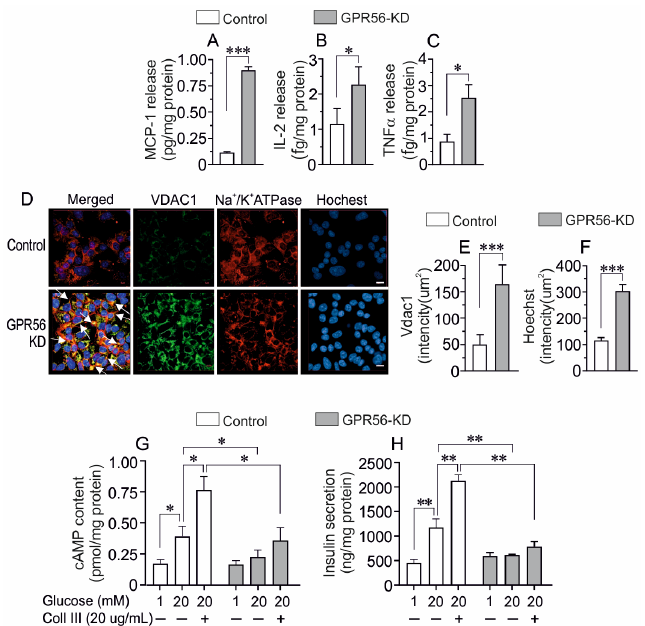
Figure 6. The effect of GPR56-KD on VDAC1 expression, cytokine release, cellular cAMP, and glu- cose-stimulated insulin secretion in human EndoC β H1 cells. GPR56-KD increased the release of MCP-1 ( A ), IL-2 ( B ), and TNF α ( C ) upon 6 h recovery culture from scramble control and GPR56-KD EndoC β H1 cells performed at six different occasions is shown. GPR56-KD increased VDAC1 ex- pression and caused its mistargeting to the plasma membrane detected as co-localization with Na+/K+ ATPase, seen as orange-yellowish fluorescence (merged) concomitant with an increased Hoechst intensity in EndoC β H1 cells ( D ) VDAC1 (green), Na + /K + ATPase (red), and Hoechst (blue). Calculation of VDAC1 intensity ( E ) and Hoechst intensity (reflecting apoptosis) ( F ) in EndoC β H1 cells shown in ( D ). The effect of Coll III on cAMP content (G) and glucose-stimulated insulin secre- tion (H) in scramble control and GPR56-KD EndoC β H1 cells incubated for 1h. The cAMP content and insulin release at basal glucose (1 mM) is included. Mean ± SEM for three experiments ( n = 3) performed at different occasions with triplicates in each group are shown. * p < 0.05; ** p < 0.01, *** p < 0.005.